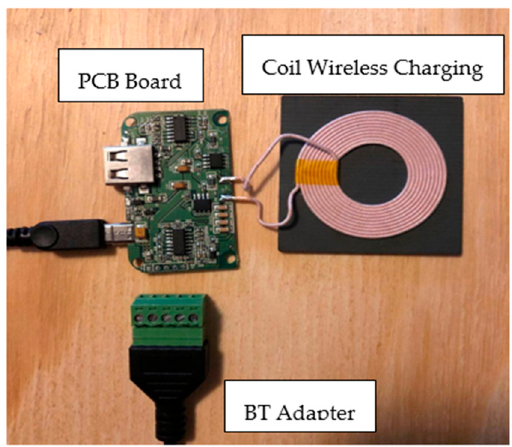
Figure 12. The Transmission Subsystem of Proposed System.